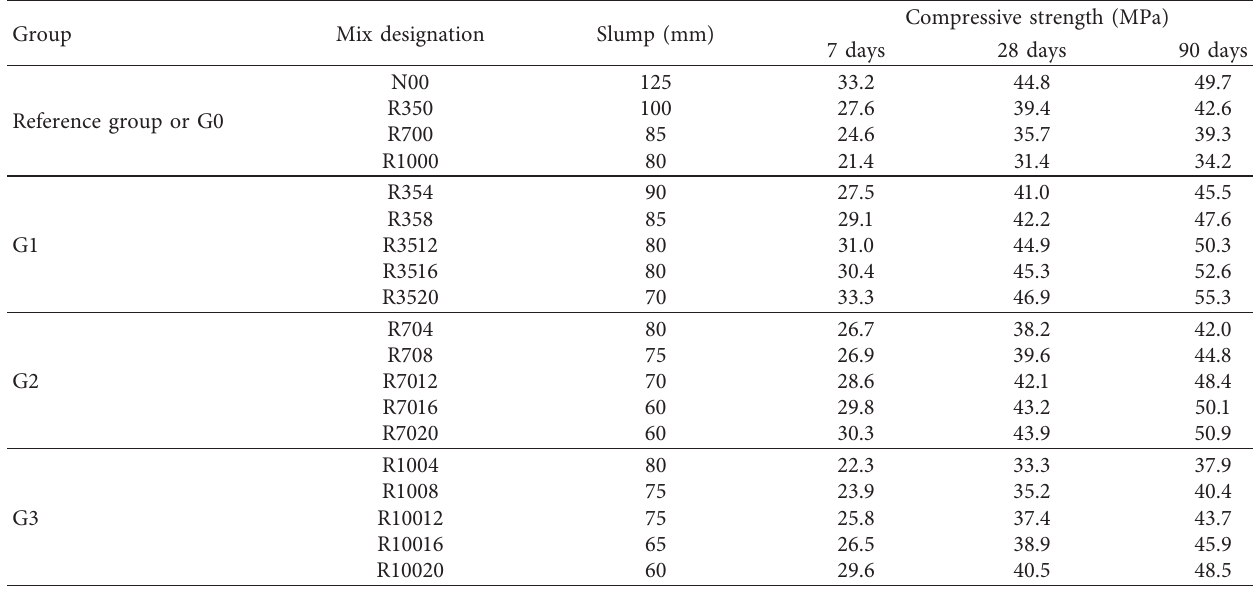
Table 4: Results of workability and compressive strength of all mixes.